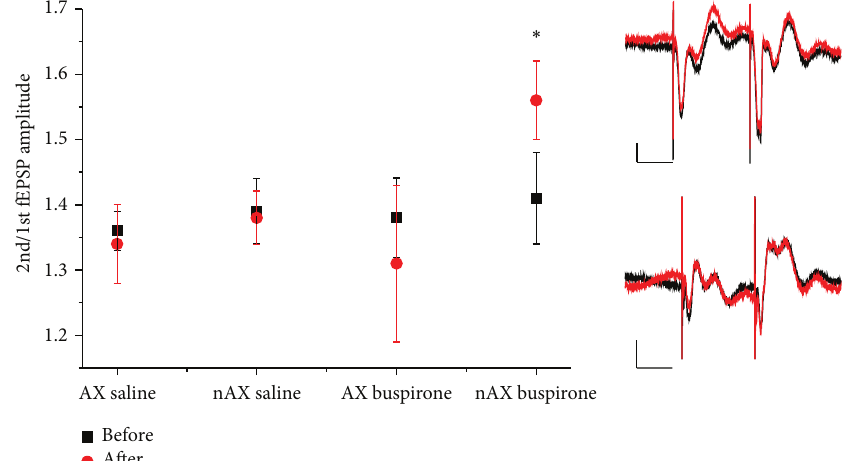
Figure 6: Paired-pulse facilitation remained unchanged after saline application in both AX and nAX strains. Buspirone did not alter PPF in the AX but increased that in the nAX mice. Insets show representative traces of AX (upper) and nAX (lower) paired-pulse fEPSPs recorded before (black) and after (red) buspirone. Note the slight reduction of fEPSP amplitude after buspirone. Calibration bars are 25 ms and 0.25 mV. ∗ 𝑃 ≤ 0.05 , paired 𝑡 -test.